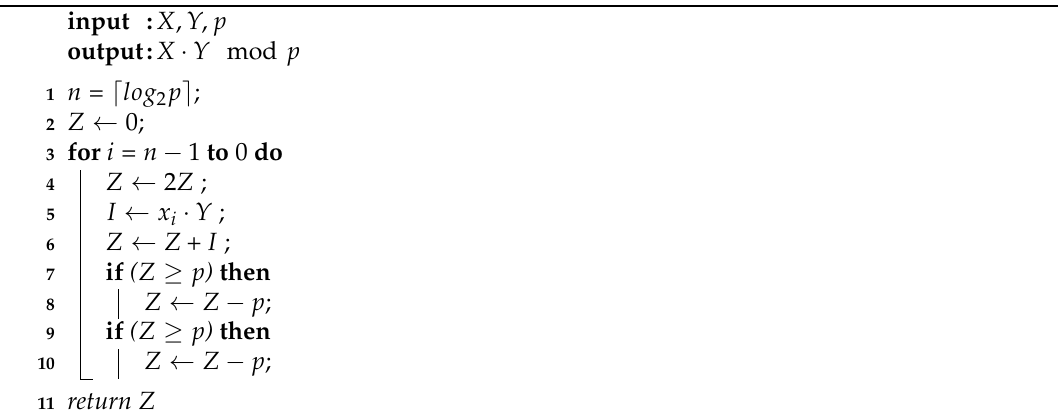
Algorithm 1: Basic interleaved modular multiplication algorithm